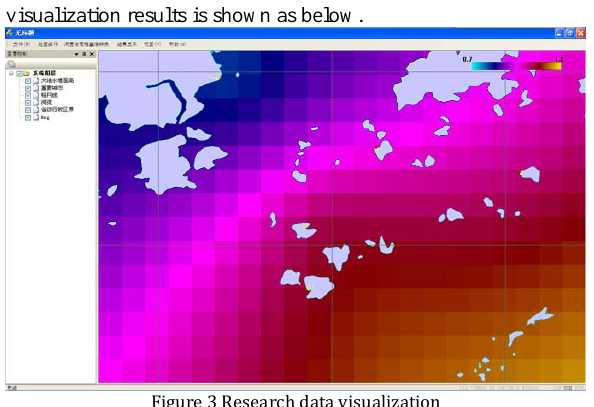
Figure 3 Research data visualization 4.2 Geographic association analysis